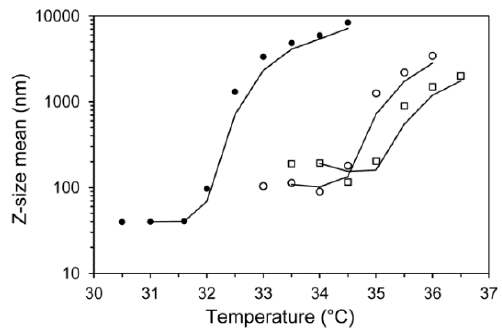
Figure 14. Mean size mean calculated by DLS as a function of the temperature for poly(OEGMA-co-DEGMA) with 24% of mol fraction of OEGMA at (●) 20 mg mL −1 in PBS, ( ○ ) 20 mg mL −1 in water, and (□) 6 mg mL −1 in water. Table 2. Collection of results from the polymers and copolymers synthesized using APP as CTA.